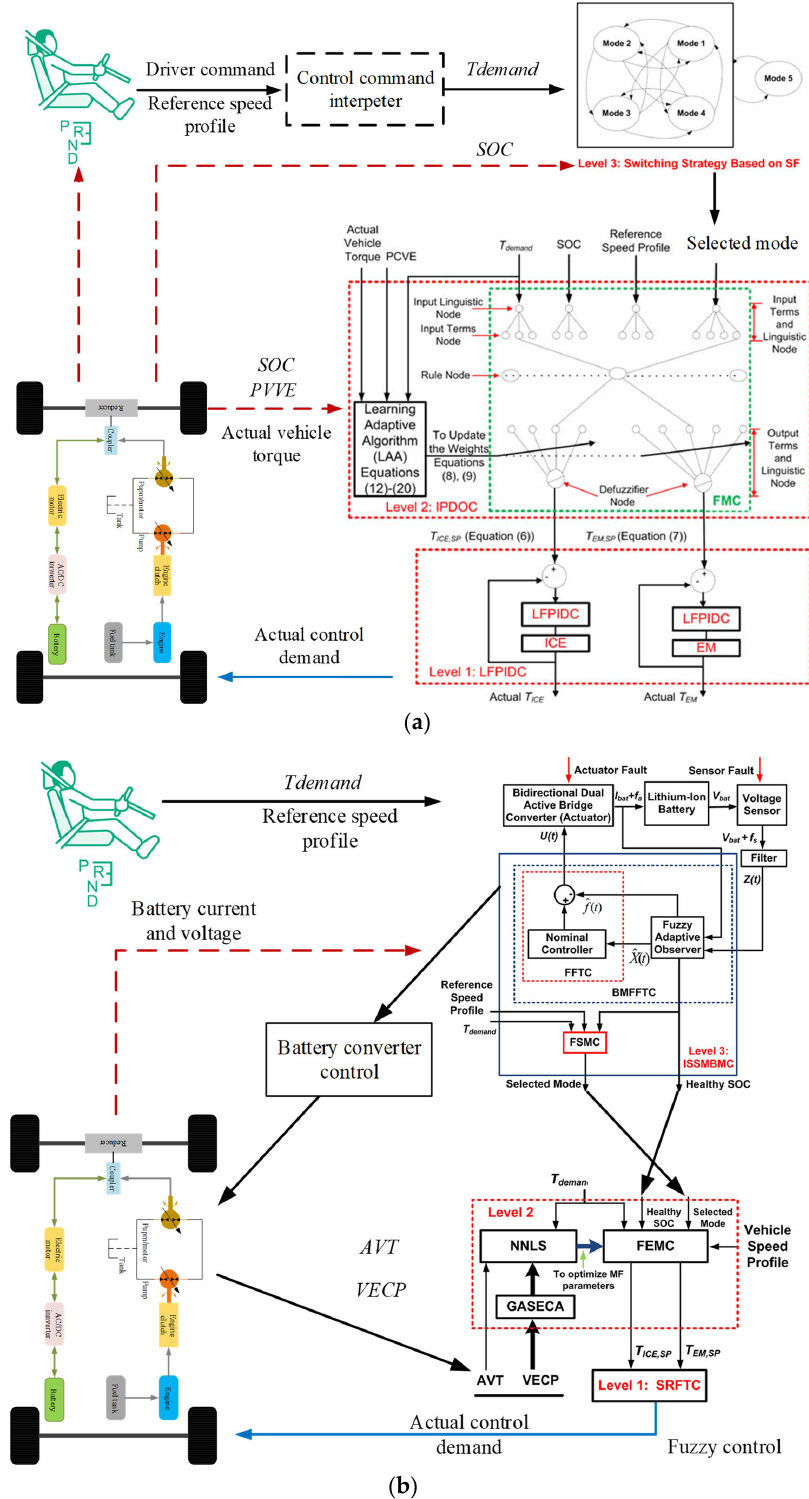
Figure 22. IHHCS and IRHHCS of hydraulic–electric buses [40,89]: ( a ) IHHCS; ( b ) IRHHCS.